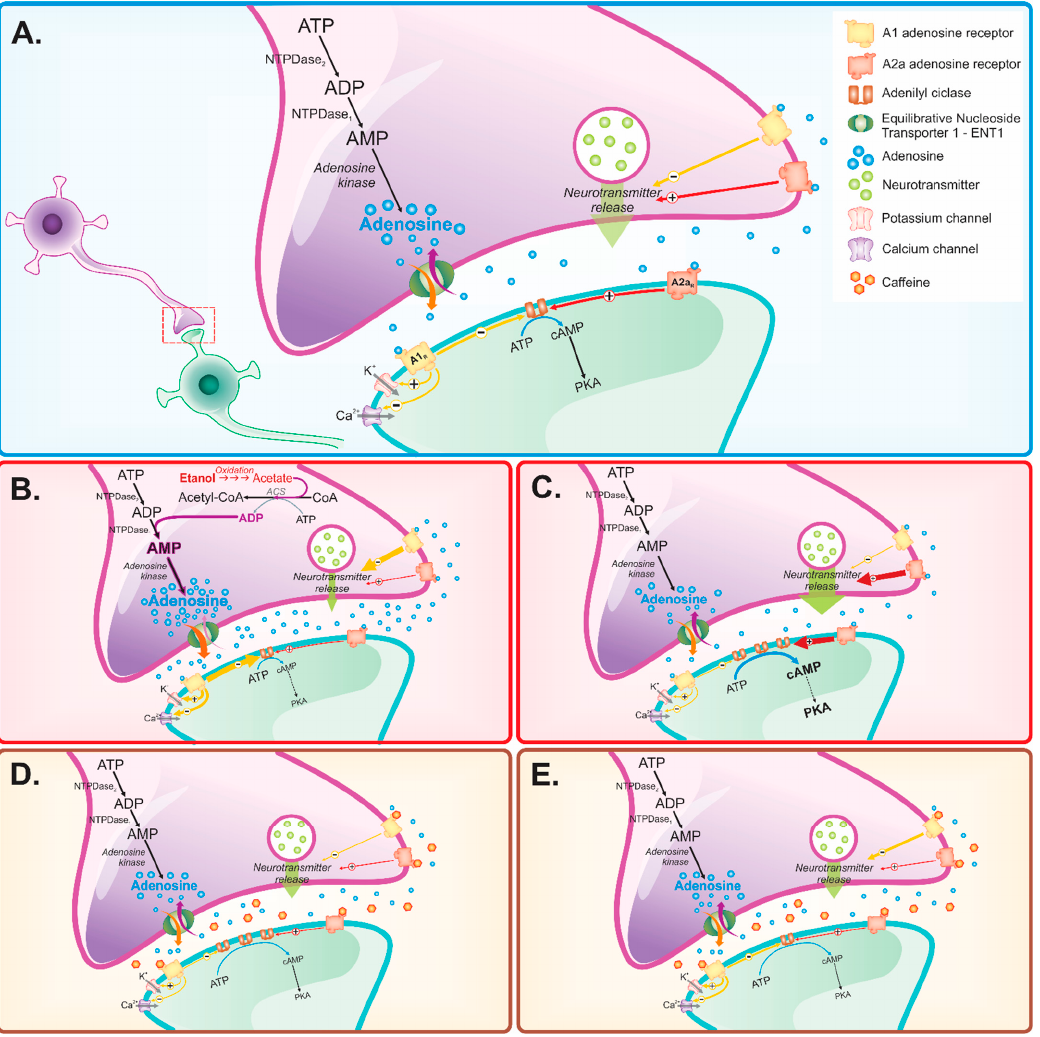
Figure 1. Adenosine action on A1 and A2A receptors promotes important regulation of neurotrans- mission in the brain ( A ); excessive consumption of ethanol has the potential to raise adenosine levels, modulating ENT1, generating increased levels and hyperactivity of adenosine in the synaptic cleft, especially acting on A1 receptors ( B ); as a consequence, neuroadaptation occurs, reducing the tone of A1 receptors, favoring the hyperactivity of A2A receptors ( C ). Caffeine, by blocking adenosine recep- tors, promote the modulation of A2A receptor-mediated hyperactivity, reducing the effects resulting from ethanol consumption ( D ), and, in the long term, could reverse neuroadaptation ( E ). Thus, in theory, caffeine could be used as a therapeutic agent to combat the deleterious effects of